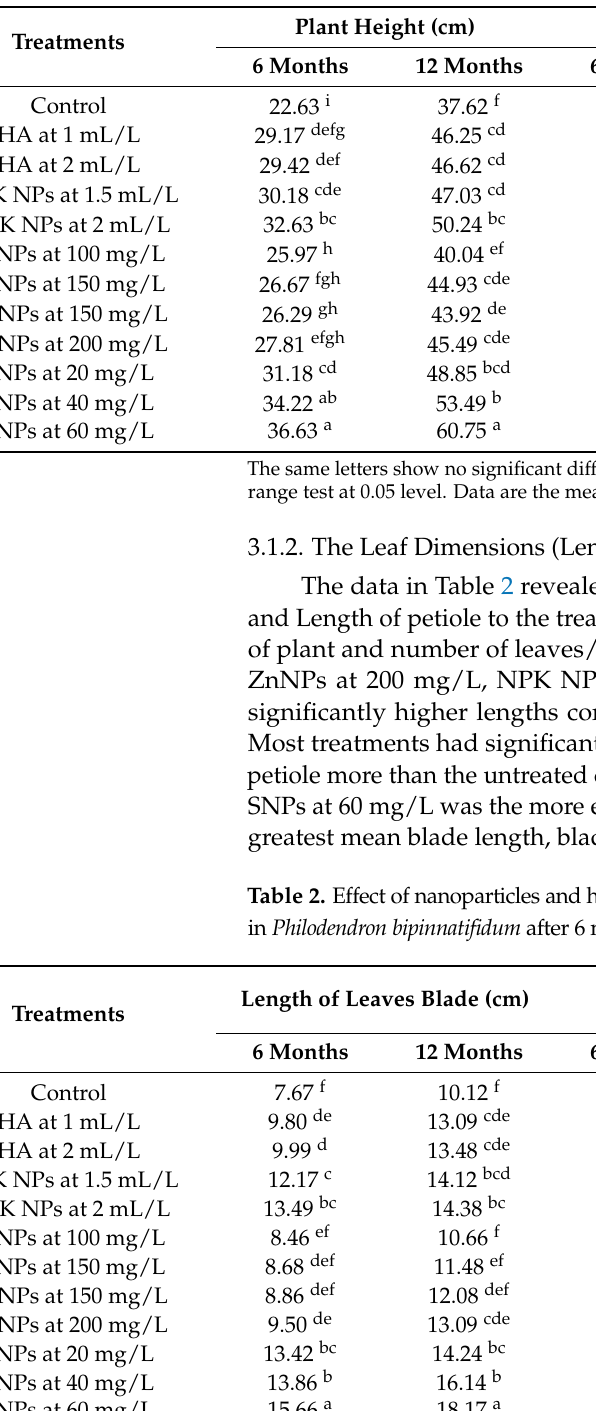
Table 1. Effect of nanoparticles and humic acid on plant height, plant width and number of leaves/plant of Philodendron bipinnatifidum after 6 months and 12 months during the 2019/2020 and 2020/2021 seasons.